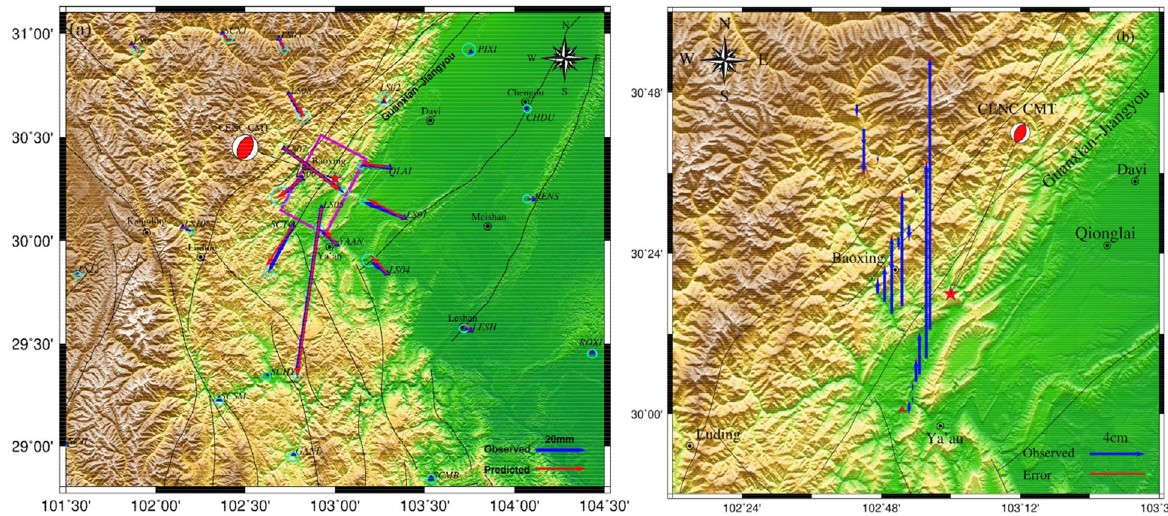
Figure 2. ( a ) The blue vector “Observed” represents the GPS observation, the red vector “Predicted” represents simulated GPS data based on the uniform fault model, the blue triangle represents the GPS continuous station, the pink rectangle represents the ground projection of the Lushan earthquake fault, The red focal mechanisms delineate the fault plane solutions of the Mw 6.6 earthquake, and the blue vector tip ellipse represents the error of the observation data. ( b ) The blue vector “Observed” represents the vertical displacement (relative to MY165 level base point) observed by the leveling station, the red straight line “Error” represents the observation error, and the red triangle represents the MY165 level base